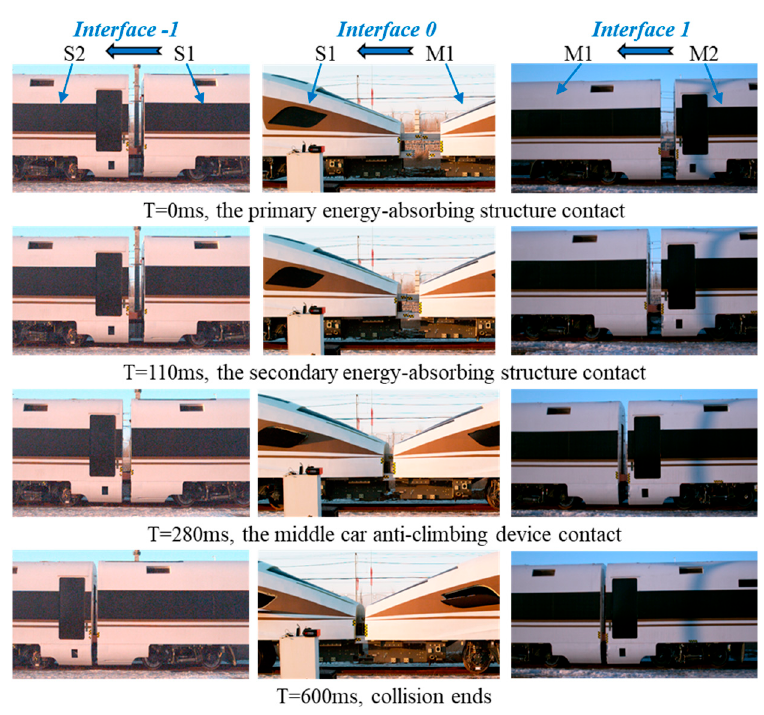
Figure 10. Sequential photos of the in–line train-to-train crash test.